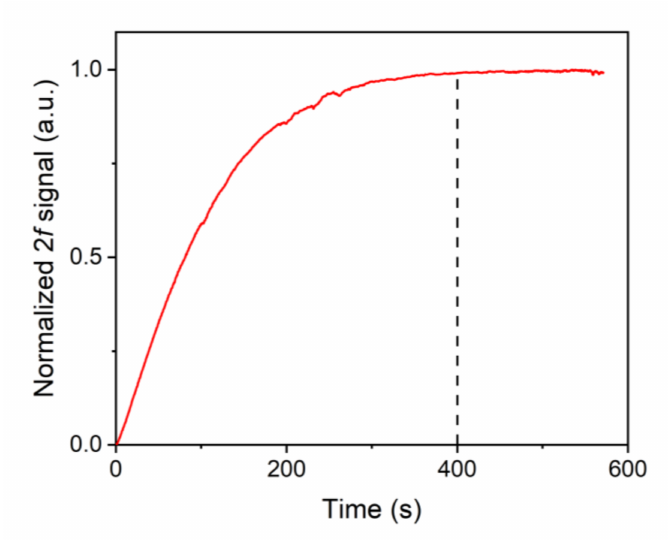
Figure 5. The correlation between normalized 2 f signal value and ventilation time.